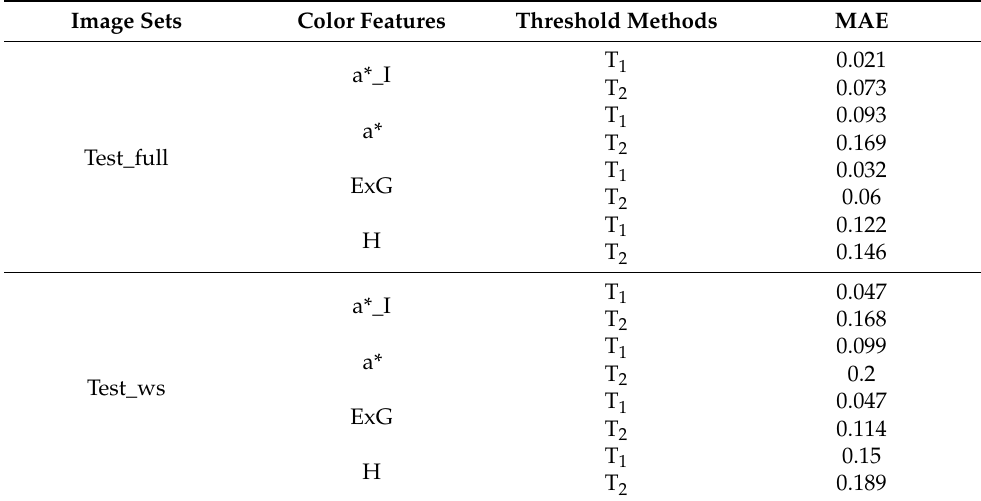
Table 4. Mean absolute error (MAE) of T 1 and T 2 methods on four color features.